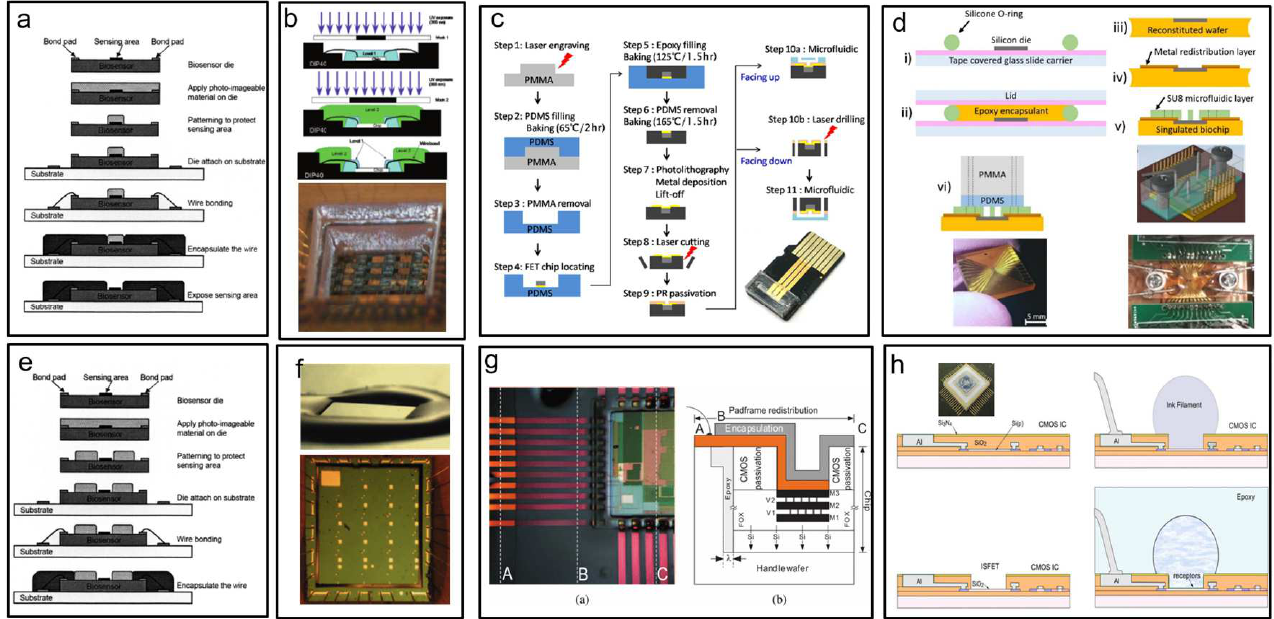
Figure 8. Current, more feasible biosensor packaging technology. ( a ) Photolithography defines the package protection layer and leaves contact holes for the sensing area on the packaged biosensor module [131]. (Copyright © 2005, In Proceedings of the 2005 7th Electronic Packaging Technology Conference.) ( b ) The high-aspect-ratio patterning of the photocurable material; the bonding wire is encapsulated with two layers of Loctite [132]. (Copyright © 2009, In Proceedings of the SENSORS, 2009 IEEE.) ( c ) The process steps of FET-based biosensor packaging, including microfluidic channels [133]. (Copyright © 2017, ECS Journal of Solid-State Science and Technology.) ( d ) Schematic diagram of laboratory-scale fan-out wafer-level packaging process [134]. (Copyright © 2018, Sensors and Actuators.) ( e ) Photolithography defines the SU-8 dam as a barrier [131]. (Copyright © 2009, In Proceedings of the SENSORS, 2009 IEEE.) ( f ) Use of SU-8 dam and halting at the dam by the surface tension of epoxy resin [132]. (Copyright © 2009, In Proceedings of the SENSORS, 2009 IEEE.) ( g ) Use of micromechanical redistribution pad frame (MRP) to package the chip, place the chip in the cavity, and rewire the pad frame, so as to realize the integration of microfluidics [132]. (Copyright © 2009, In Proceedings of the SENSORS, 2009 IEEE.) ( h ) Direct ink writing (DIW) used to form a microfluidic system (MFS) can quickly package and produce integrated circuits with sensors [135]. (Copyright © 2017, Materials Science in Semiconductor